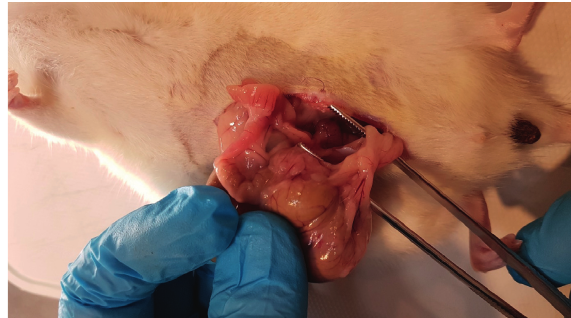
Figure 3: Macroscopic adhesion score 2 case from the 3% sodium pentaborate group.